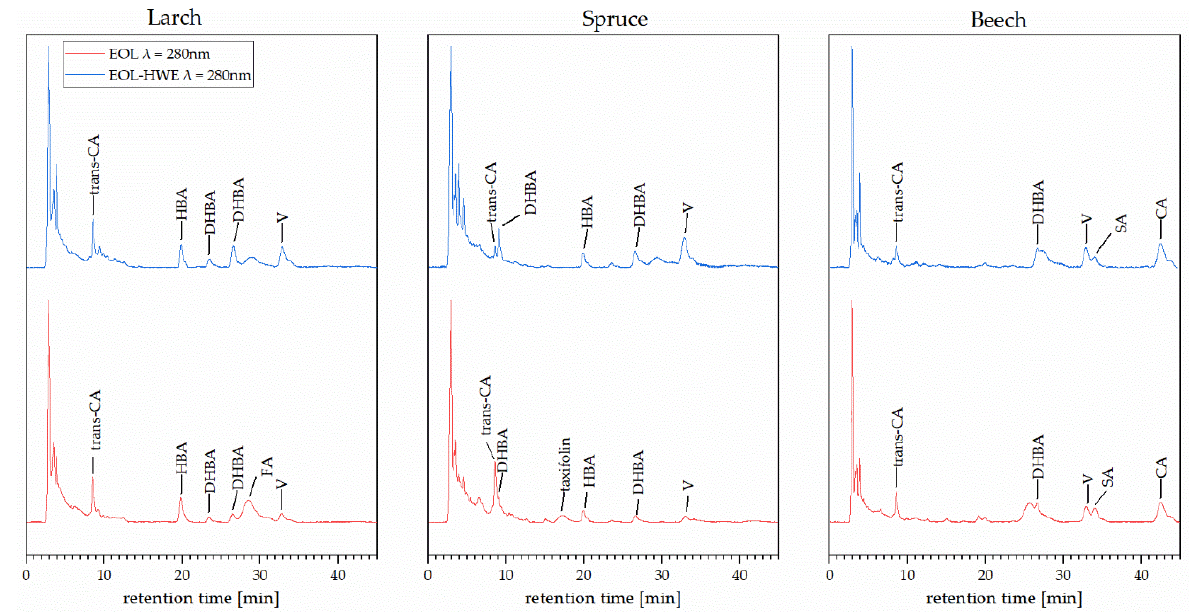
Figure 7. Chromatograms of extracted organosolv lignin with and without pretreatment. Table 2. Relative integrated peak area [%] of identified compounds from While the identified peaks from the hot water extracts (HWE) are mostly assigned to flavonoids and flavonoid glycosides, a majority of compounds identified in the organo- solv fractions (EOL and EOL–HWE) consist of different organic acids. If no hot water